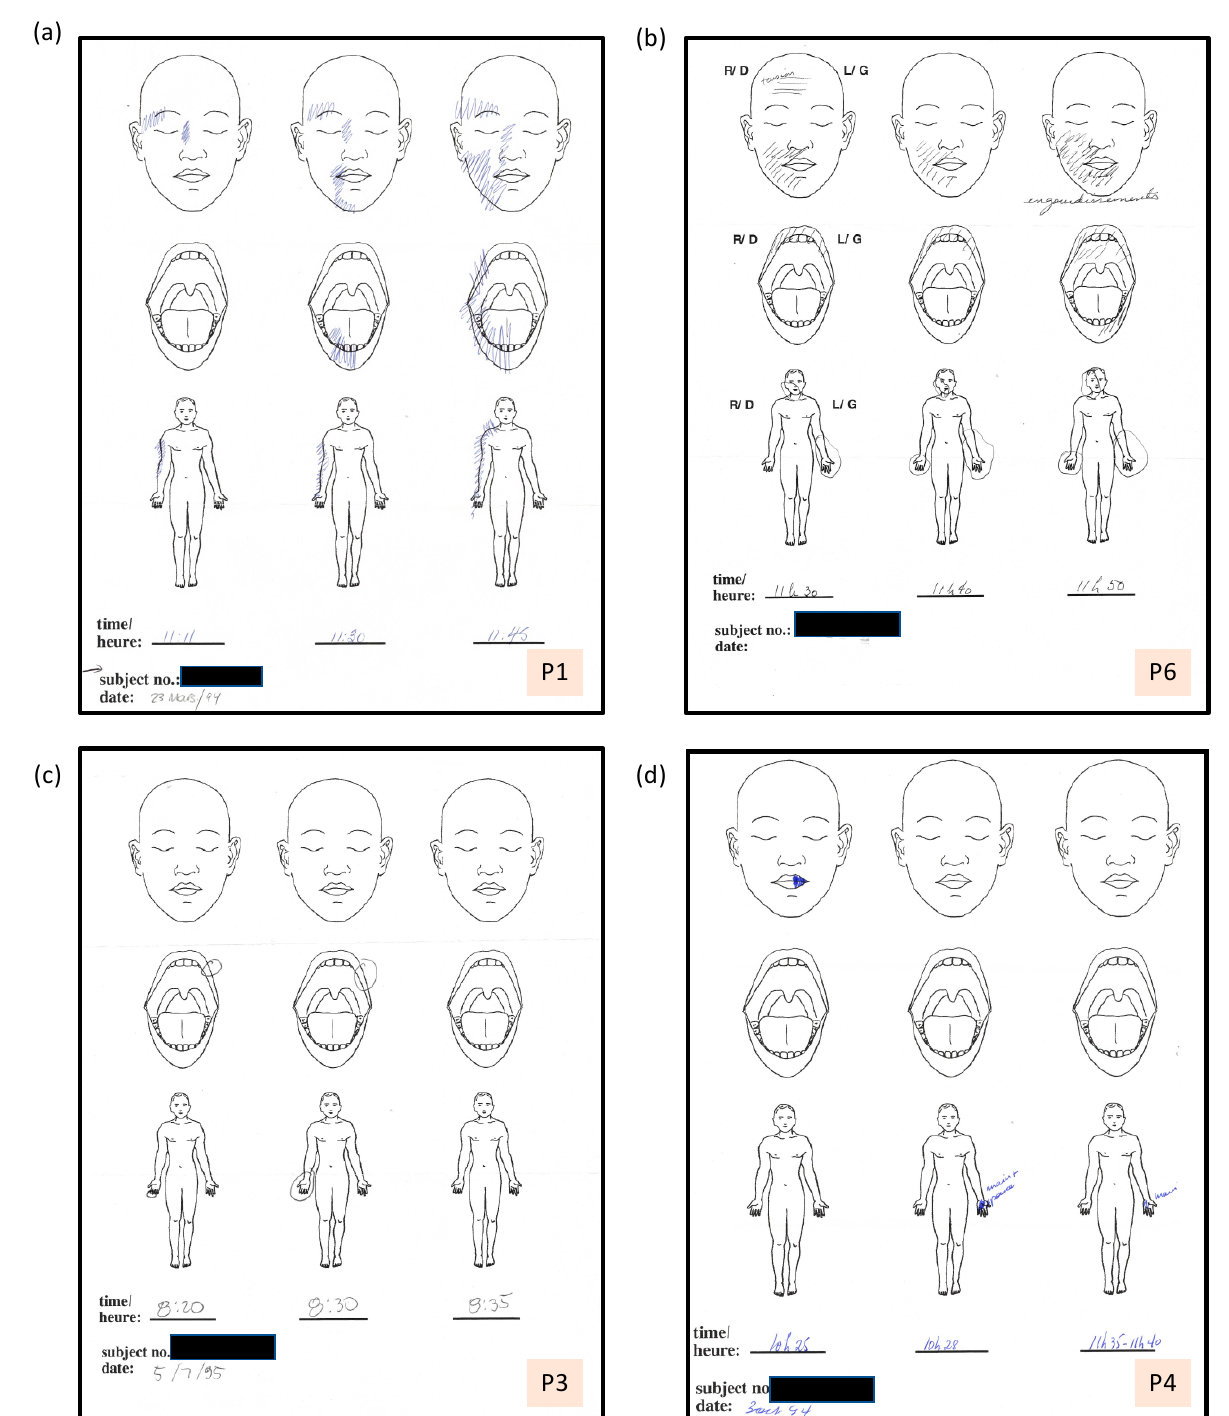
Figure 2. Sets of three somatosensory maps from single episodes recorded by four participants. ( a ) P1: Maps of unilateral aura symptoms on the face and arm ( b ) P6: Maps of a bilateral aura with mirror image regions of the hand affected beginning first on the left and more extensive on this side. The facial numbness (“engourdissements”) is largely on the right but spread across the midline to include the lower left lip and chin over 20 min. ( c ) P3: Somatosensory aura illustrating simultaneous aura symptoms in different body regions on opposite sides of the body. ( d ) P4: Unilateral aura showing localized symptoms in the lip, followed by the hand and thumb shortly after onset. The symptoms disappeared, and then reappeared briefly an hour later, as indicated in the third drawing.